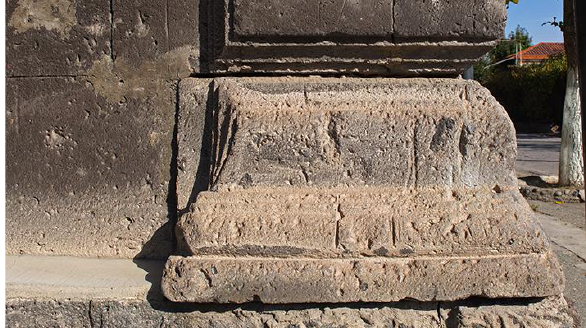
Figure 18. Gukasyan Street, 146. Detail. Photo by the author,